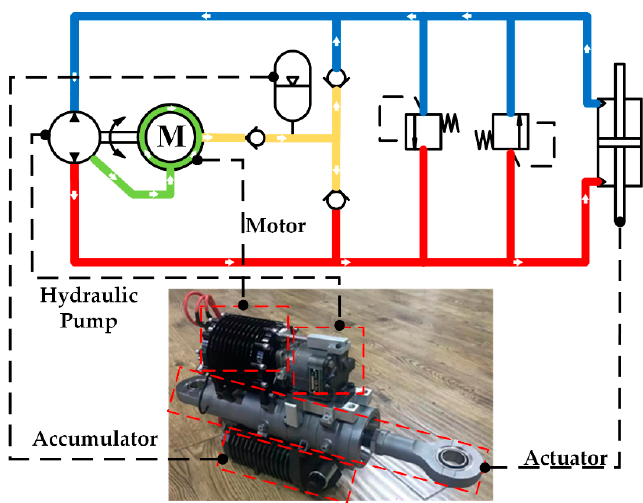
Figure 1. Highly integrated electro-hydrostatic actuator (EHA) system.